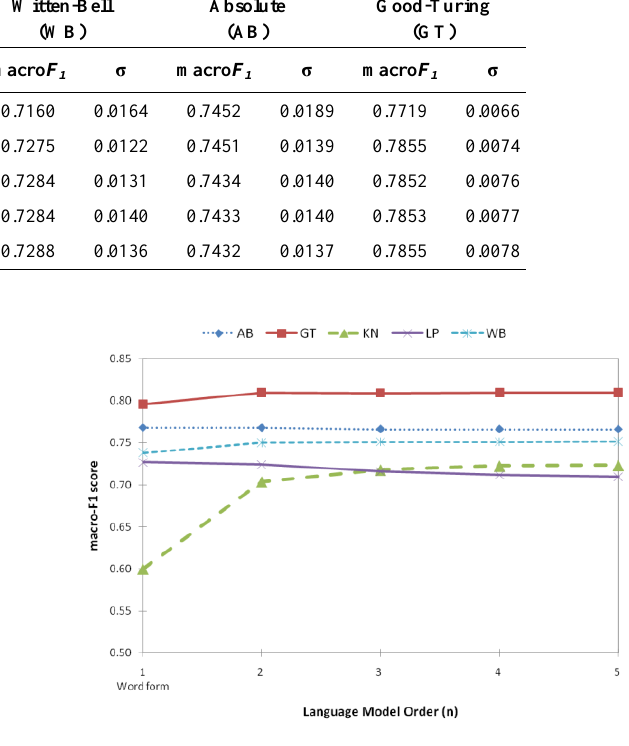
Fig. 2. Performance of word form based language models with different smoothing methods along with language model order